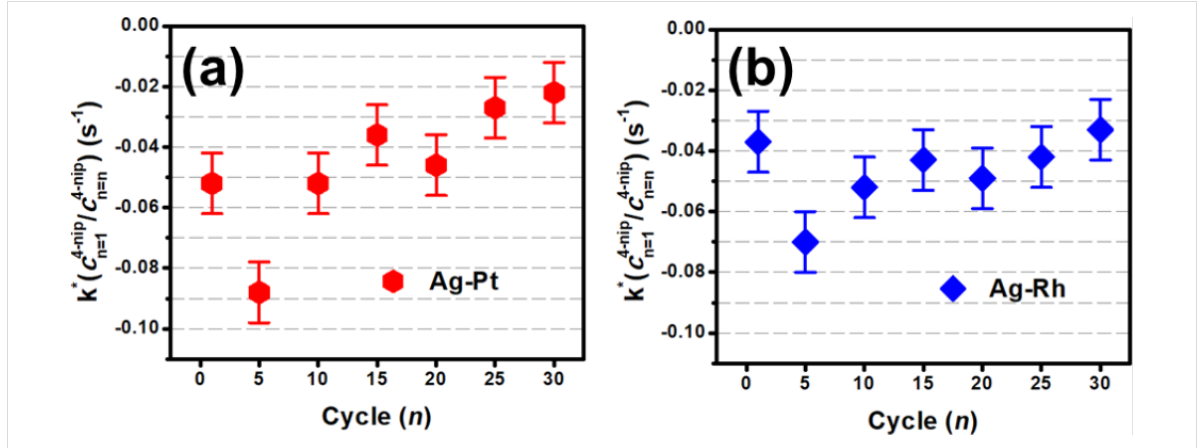
Figure 4: Rate constants for 1:1 loading ratios of the (a) Ag–Pt and (b) Ag–Rh systems over the course of 30 reduction cycles. The rate constant k is normalized for the diminishing concentration of 4-nitrophenolate over the cycling experiment. Errors bars represent the standard deviation of six sepa- rate determinations of k for 1:1 Ag–Rh.